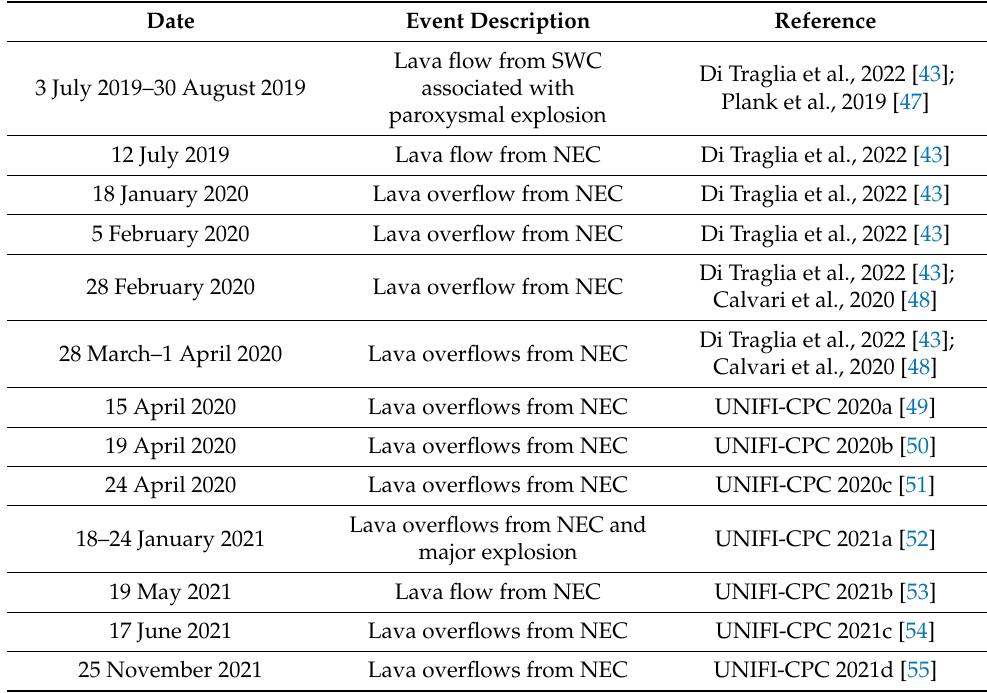
Table 4. Events occurred at Stromboli volcano between June 2019 and July 2020. The position of South West Crater (SWC) and North East Crater (NEC) is shown in Figure